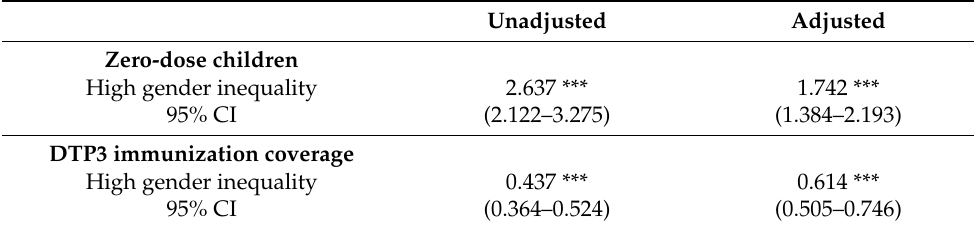
Table 3. Odds ratios for zero-dose DTP prevalence and DTP3 immunization coverage by SGDI category (702 subnational regions across 57 countries, 2010–2019).